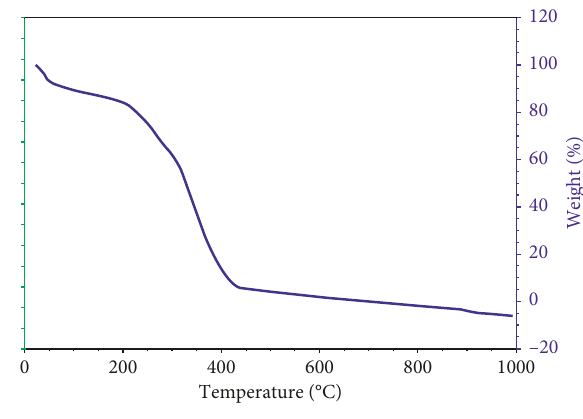
Figure 3: TGA curve